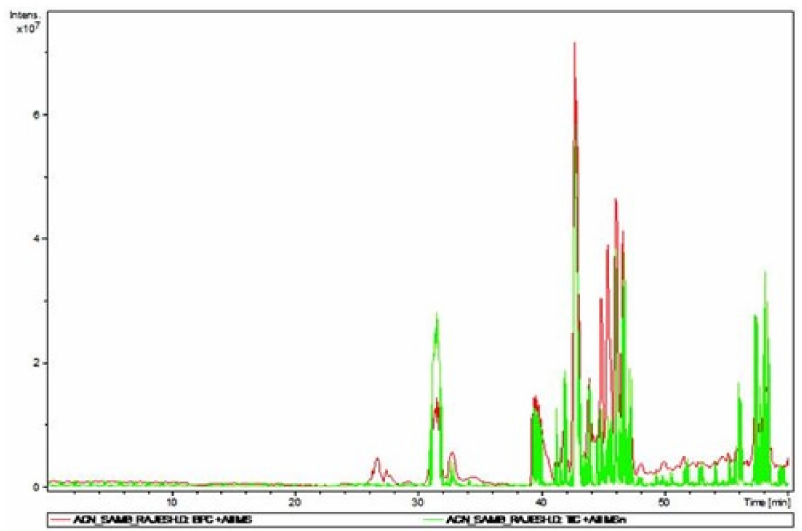
Figure 1. Total ion chromatogram of natural extract of S. amaranthoides .